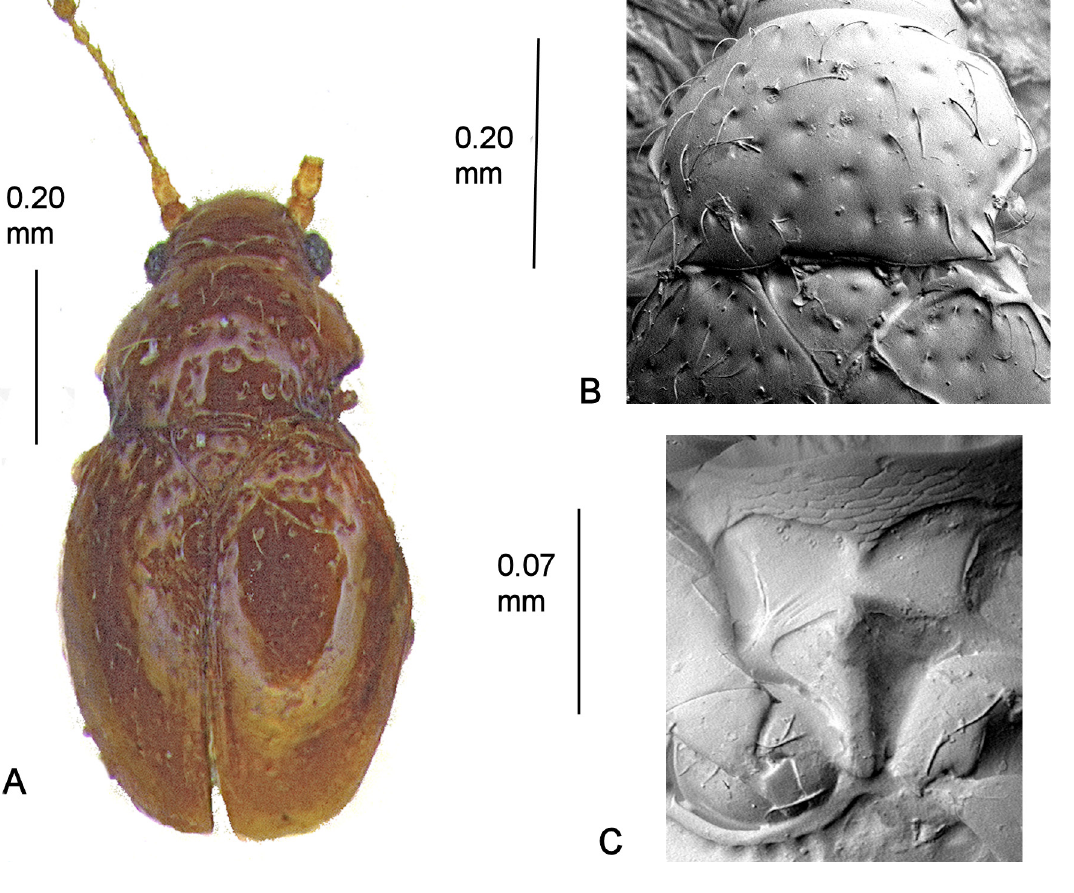
Fig. 114. Cissidium waginicum sp. nov. A . Habitus. B . Pronotum, × 455. C . Mesoventrite showing median process of collar, mid-keel and keel, ×